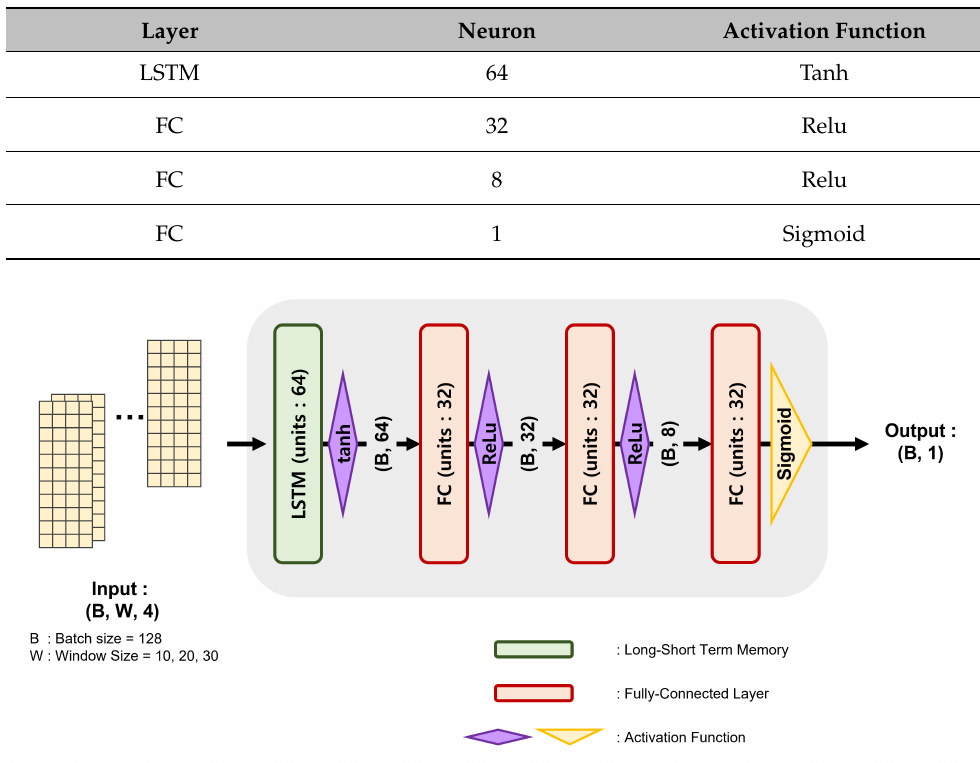
Figure 5. A diagram of proposed network and